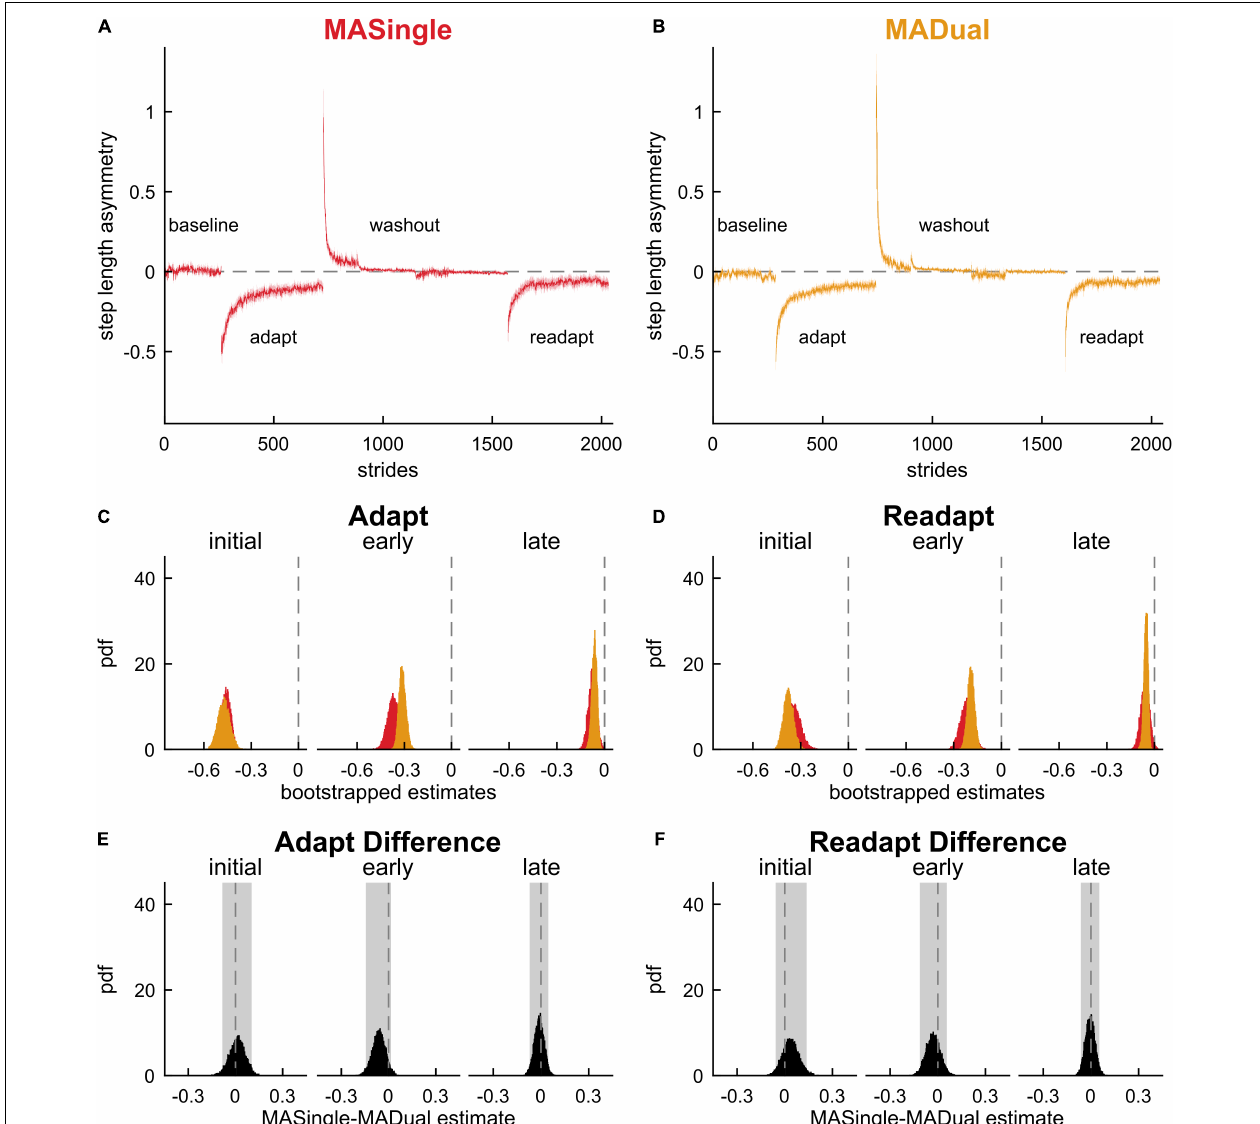
FIGURE 7 | Motor adaptation and readaptation in single- and dual-tasking late middle-aged adults. Step length asymmetry time course (mean and shaded SE) for (A) single-tasking (MASingle, red) and (B) dual-tasking (MADual, orange) late middle-aged adults. (C) PDF of adaptation time epochs: initial (strides 1–5), early (strides 6–30), late (last 30 strides). (D) PDF of the same time epochs in readaptation. (E) PDF of the difference of the means between MASingle and MADual for adaptation time epochs. (F) PDF of the difference of the means between MASingle and MADual for readaptation time epochs. Lighter shaded areas of PDF plots indicate the 95% CI. PDFs and CIs are obtained through bootstrapping. Motor adaptation and readaptation are not significantly different between MASingle and MADual